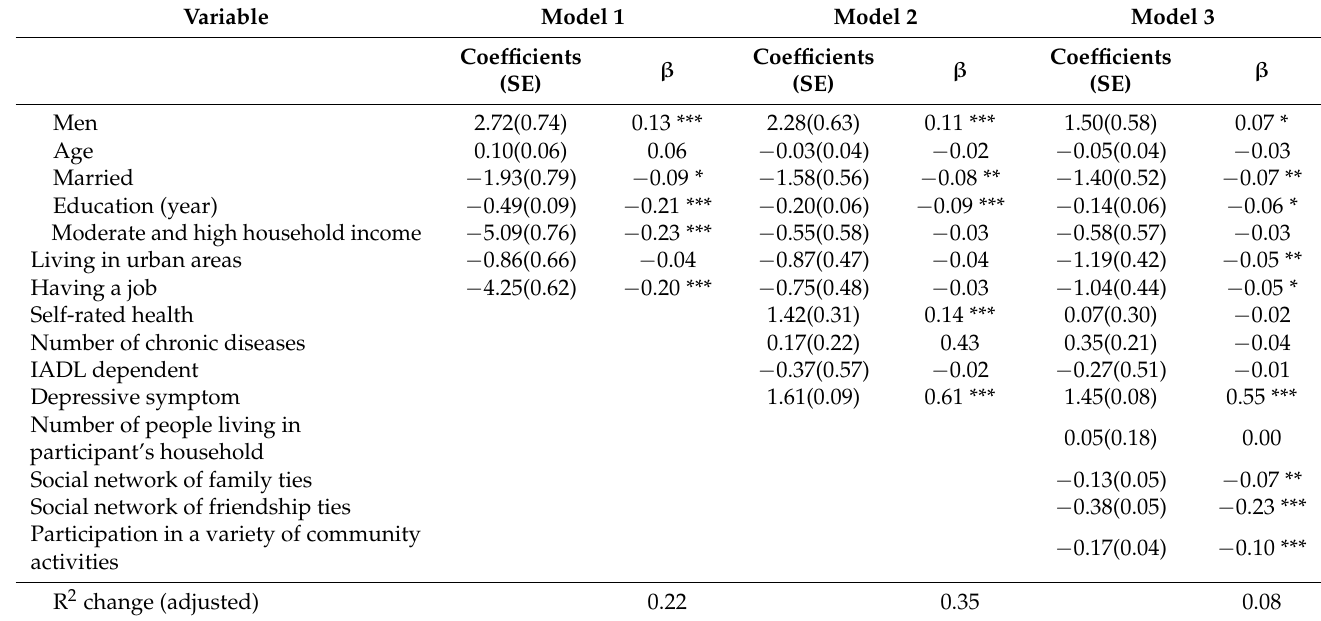
Table 2. Multivariate hierarchical regression model predicting loneliness for total